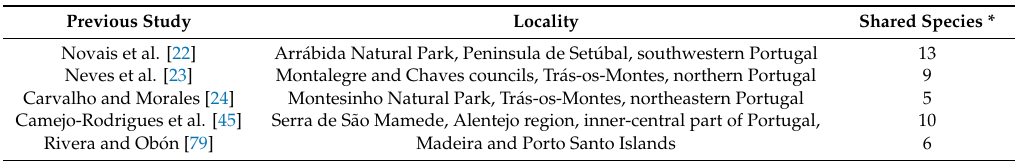
Table 2. Comparative review of literature on the studied medicinal plants used in di ff erent regions across the